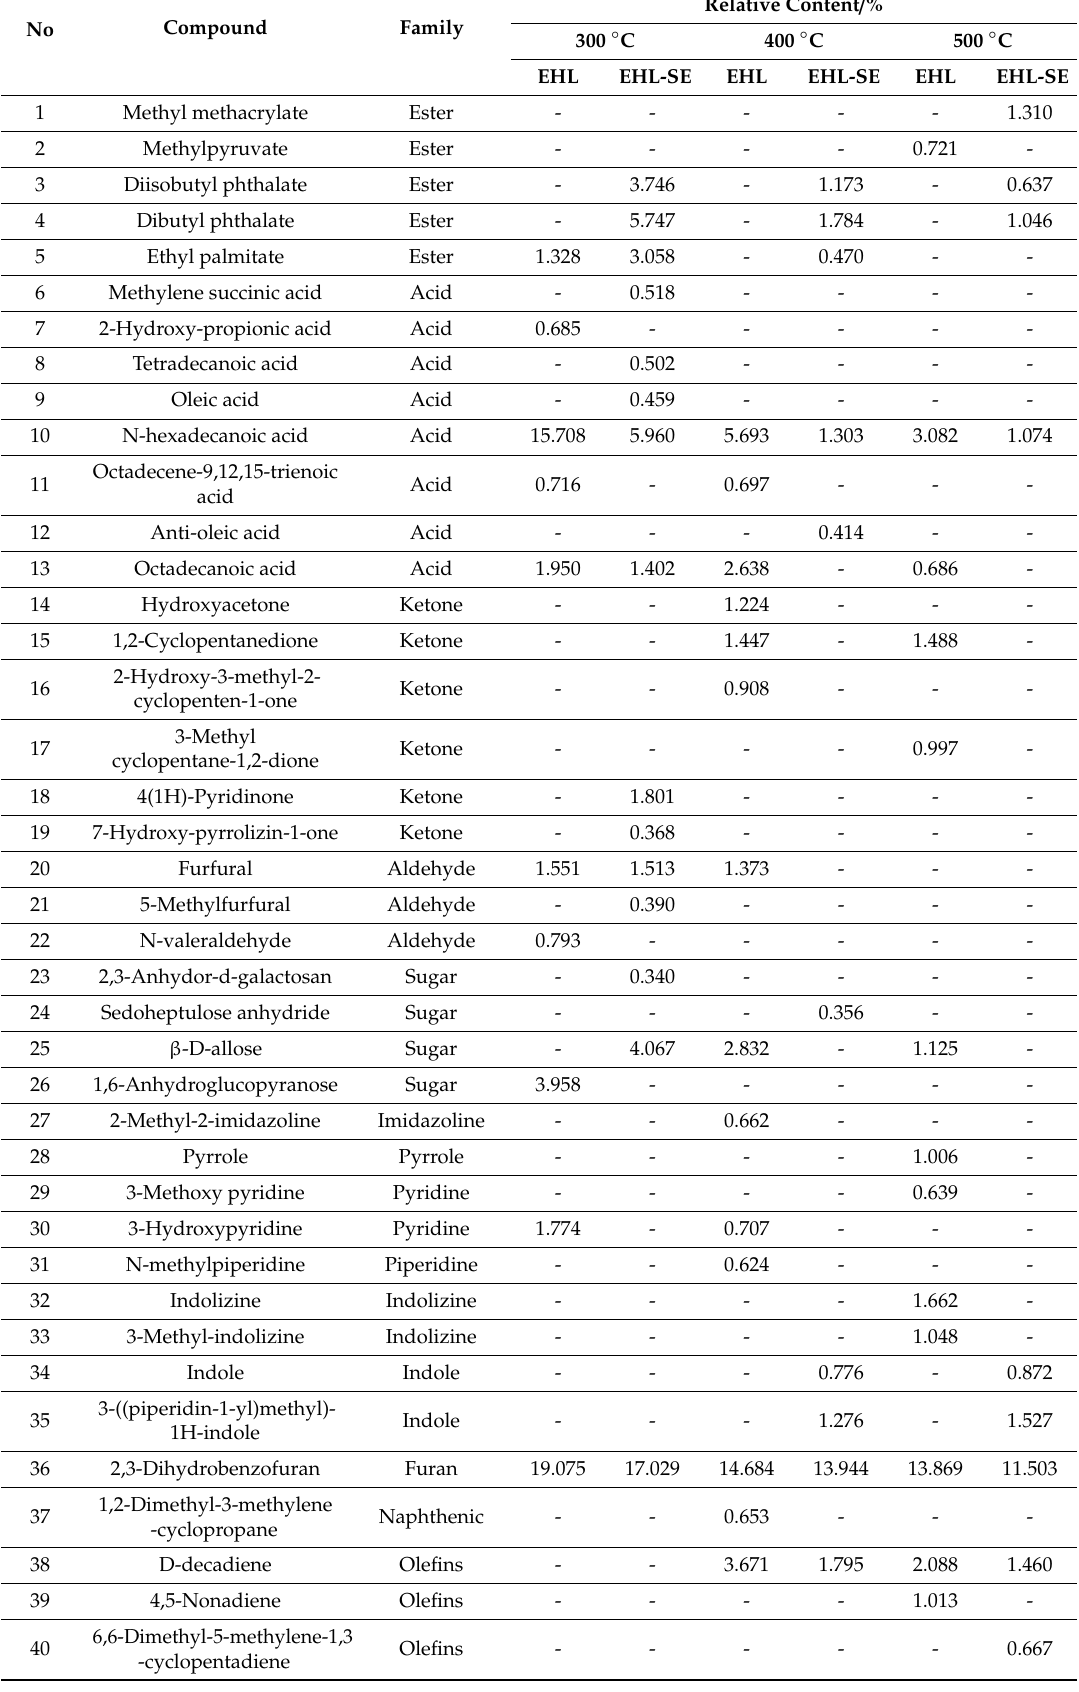
Table 2. Comparison of pyrolysis products of two raw materials at di ff erent